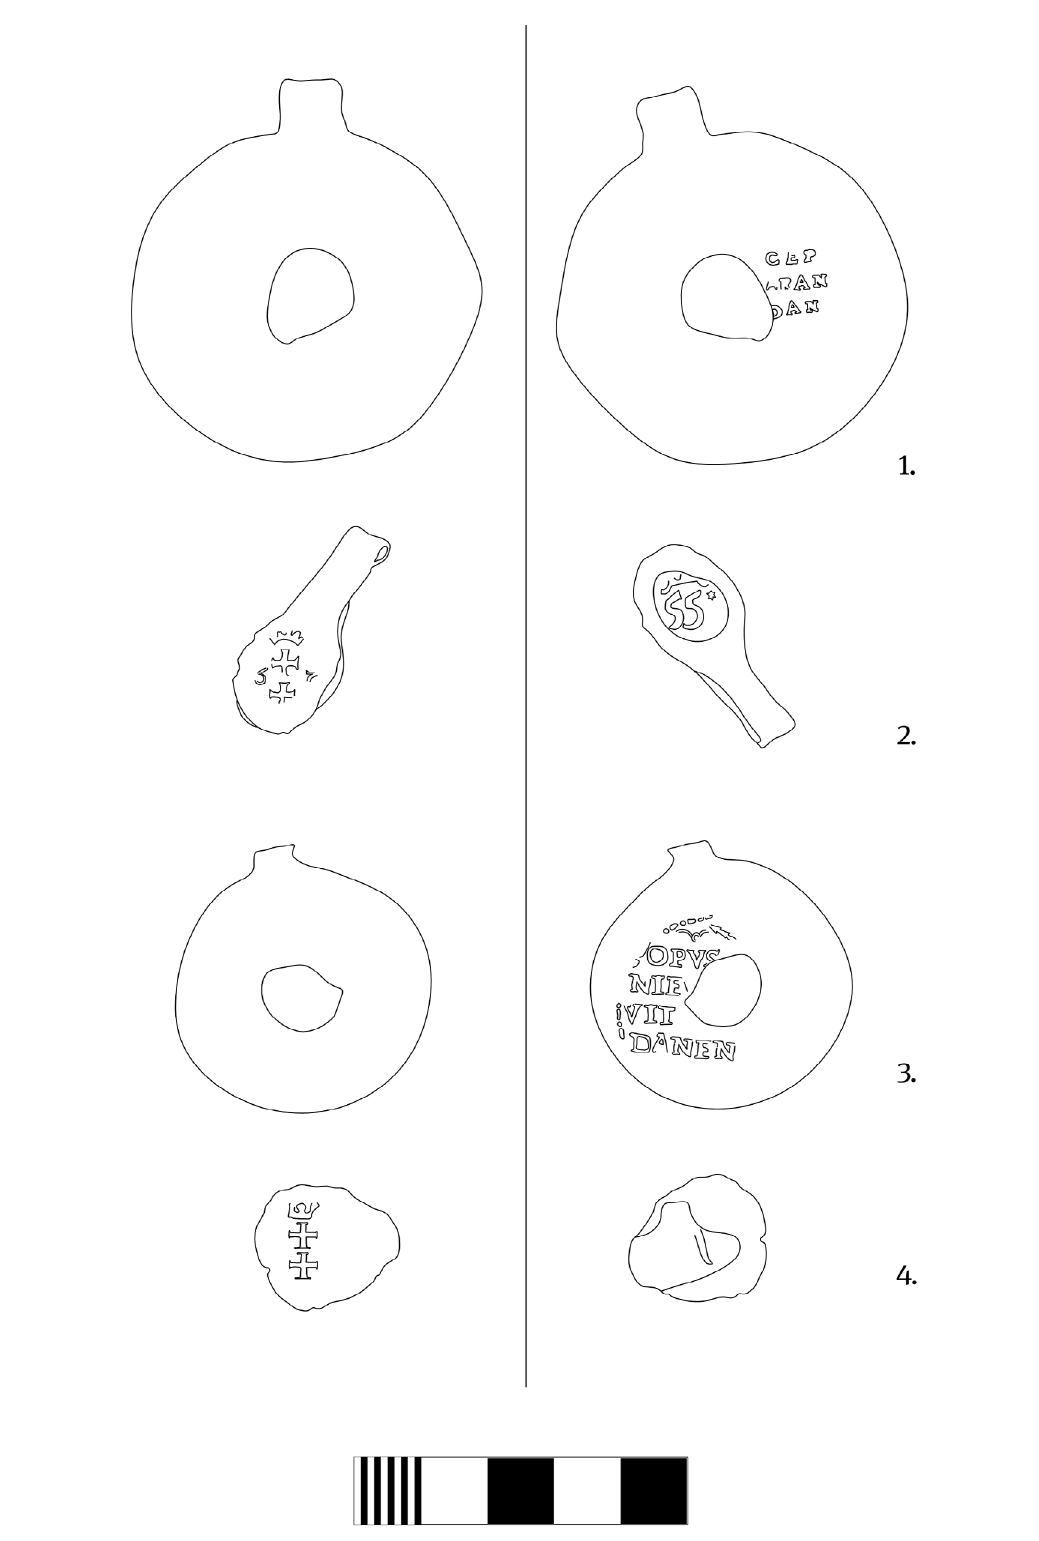
Figure 29. Lead seals originated from Gdańsk